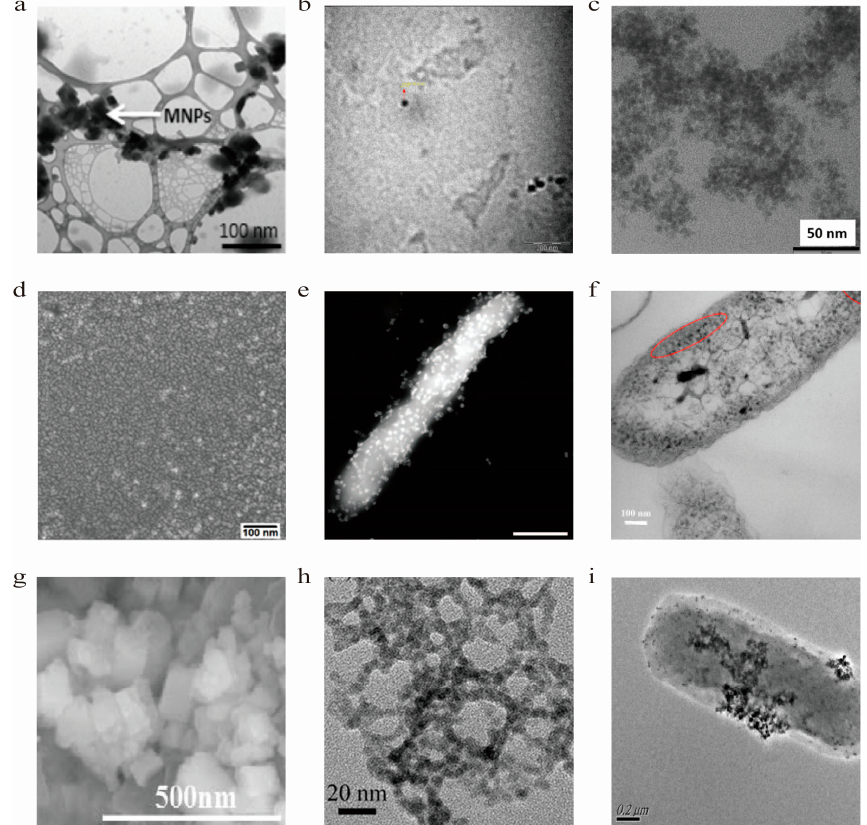
Figure 3. SEM and TEM images of biosynthesized compounds. ( a ) Fe 3 O 4 by Luteinizing Hormone